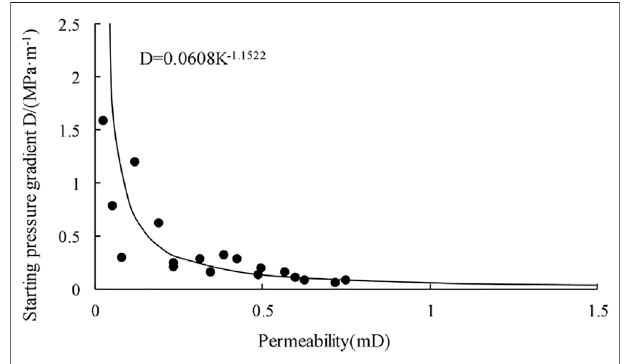
FIGURE 4 | Relationship between permeability and starting pressure gradient of the Chang 6 reservoir in Block